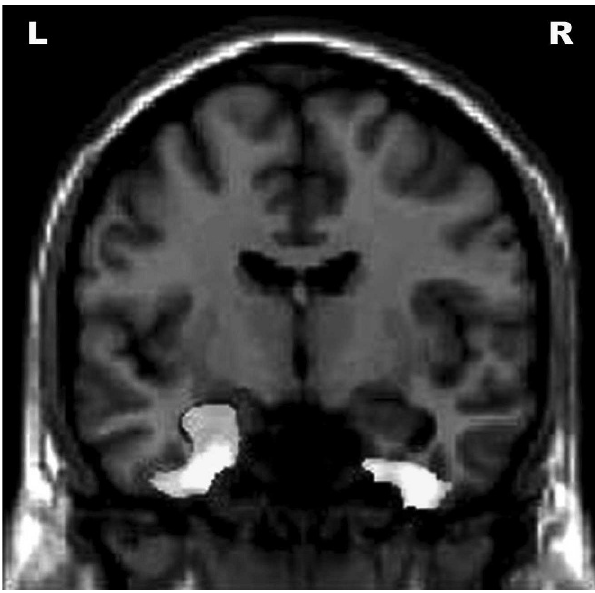
Figure 3 - Correlations between Disability Assessment for Dem- entia scores and reduced grey matter volume in different areas of the brain. Results are displayed at an uncorrected p , 0.001 level and plotted onto the SPM5 canonical T1 image for the purpose of illustration. R = right; L